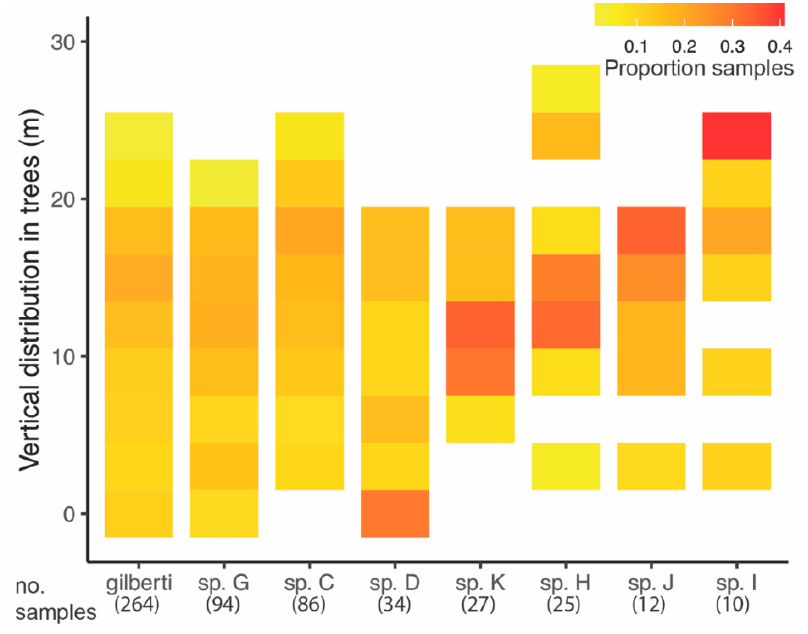
Figure 14. Vertical distribution of Anonychomyrma species sampled in 105 surveys (out of 525 total surveys) from ground to canopy at 15 elevation sites at four subregions in the AWT. Pooled occurrence data from four subregions across the Australian Wet Tropics, with species ordered by number of survey occurrences from left to right. Each tile represents a 3-metre vertical band, coloured by proportion of total sample occurrence for each species. Numbers beneath species labels are total number of sample occurrences for that species (total samples = 3745). The maximum potential tree survey height for each species (based on occurrence in each surveyed tree) is: gilberti = 27 m, sp. G = 27 m, sp. C = 24 m, malandana = 24 m, sp. K = 24 m, sp. H = 27 m, sp. J = 21 m, sp. I = 24 m. Red represents high proportion of samples and yellow represents low proportion of